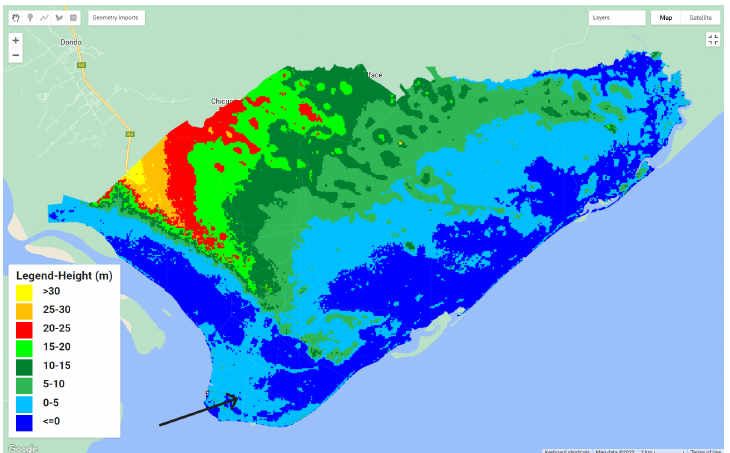
Figure 2. A 90 m resolution USGS digital elevation model (DEM) of the Beira municipality with all its 26 neighborhoods. It can be seen that the center of the city (area indicated by the arrow) is located in a low elevation